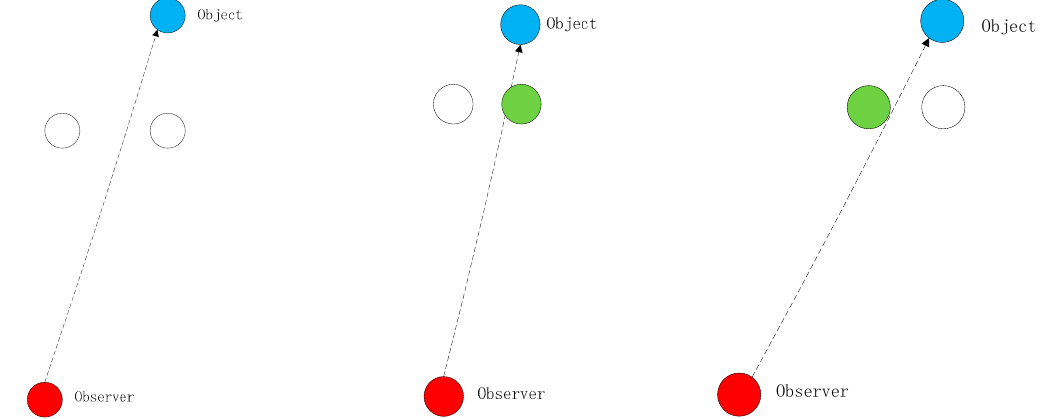
Figure 11. Visibility judgment: the visibility between the observation point and the target object point is related to the height of the two auxiliary points between them. When the angle of observation (denoted by the dotted arrow) is different, the weights of visibility of the two reference points are different.